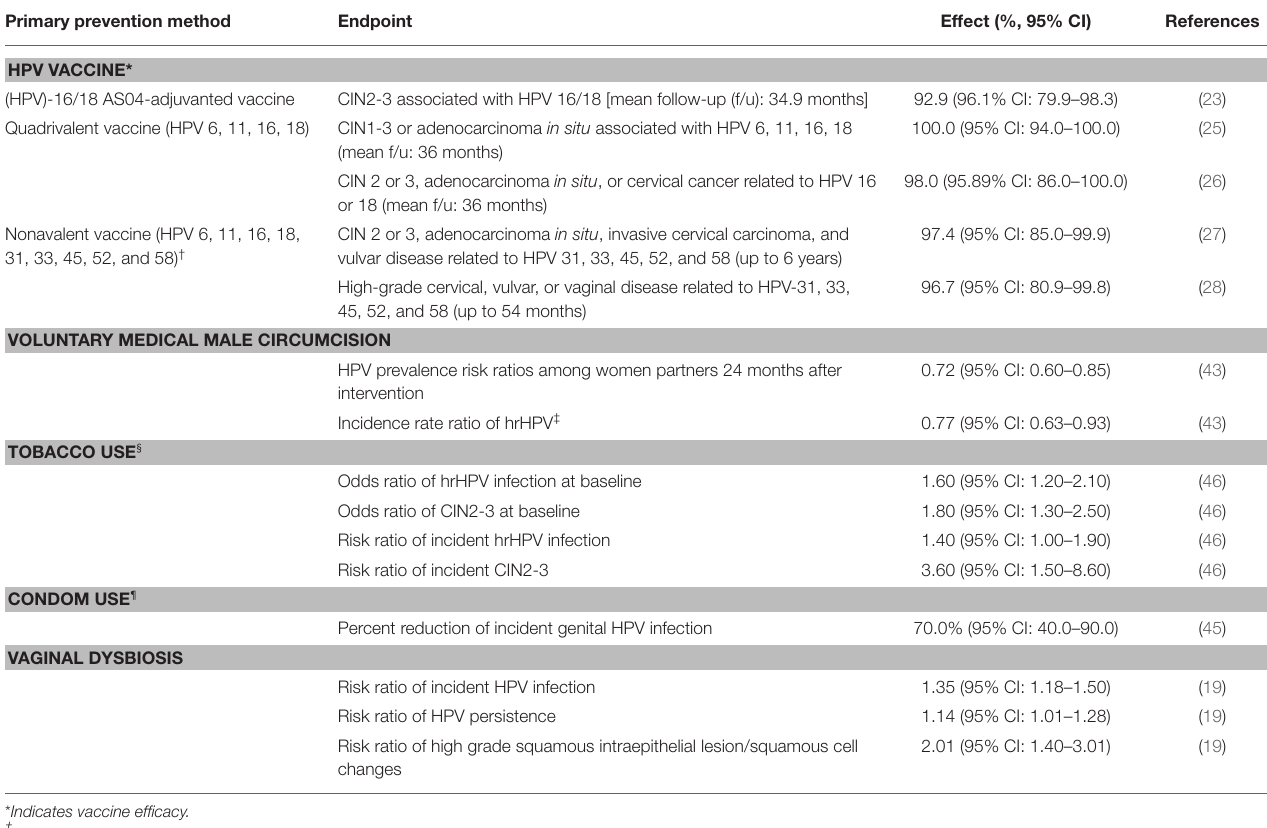
TABLE 3 | Summary of HPV vaccine efficacy and effect of co-factors on HPV-related clinical